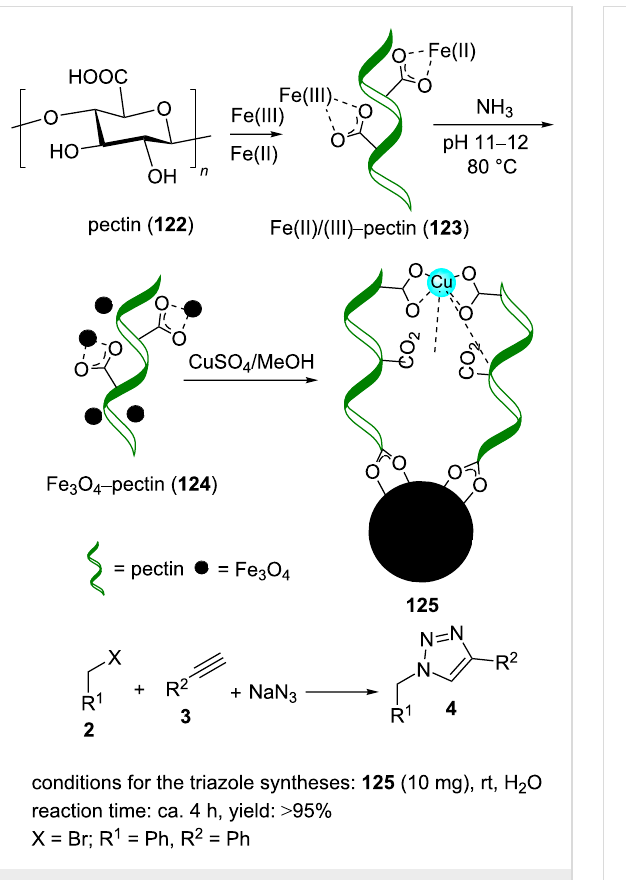
Scheme 27: Synthetic route to 125 and application of 125 in “click”